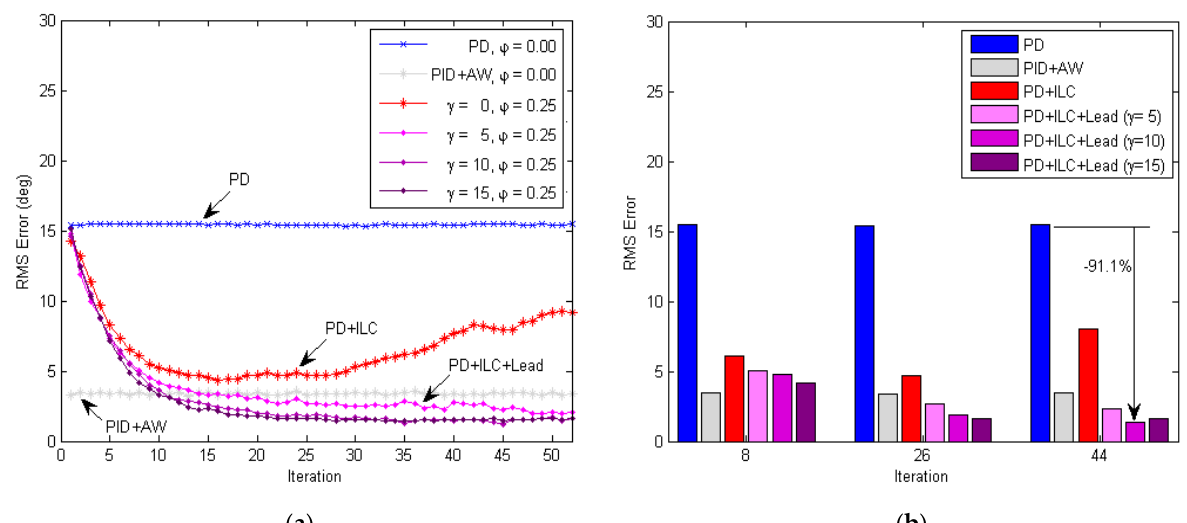
Figure 20. Comparison of the RMS tracking error using different control methods. ( a ) Iteration-domain convergence of the RMS knee joint tracking error. The RMS error of the PD and PID + AW control stays roughly unchanged over repetitions as expected. The RMS error of PD + ILC control decreases for the first 17 iterations and then diverges. The RMS error of PD + ILC + Lead control converges monotonically at different speeds. ( b ) Comparison of the RMS tracking error at different iteration numbers (#8, #26 and #44). Overall, the PD + ILC + Lead ( 𝛾 = 10 ) performs the best, achieving 91.1% error reduction at iteration #44, compared with the PD control.